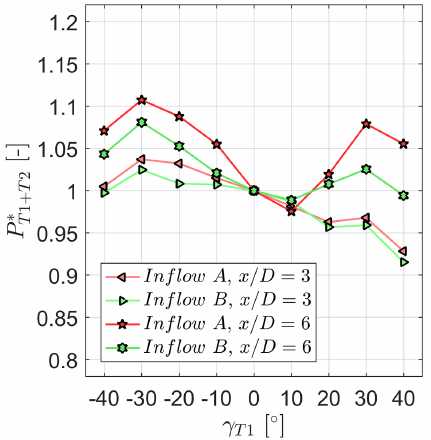
of two turbines for dif- T1 + T2